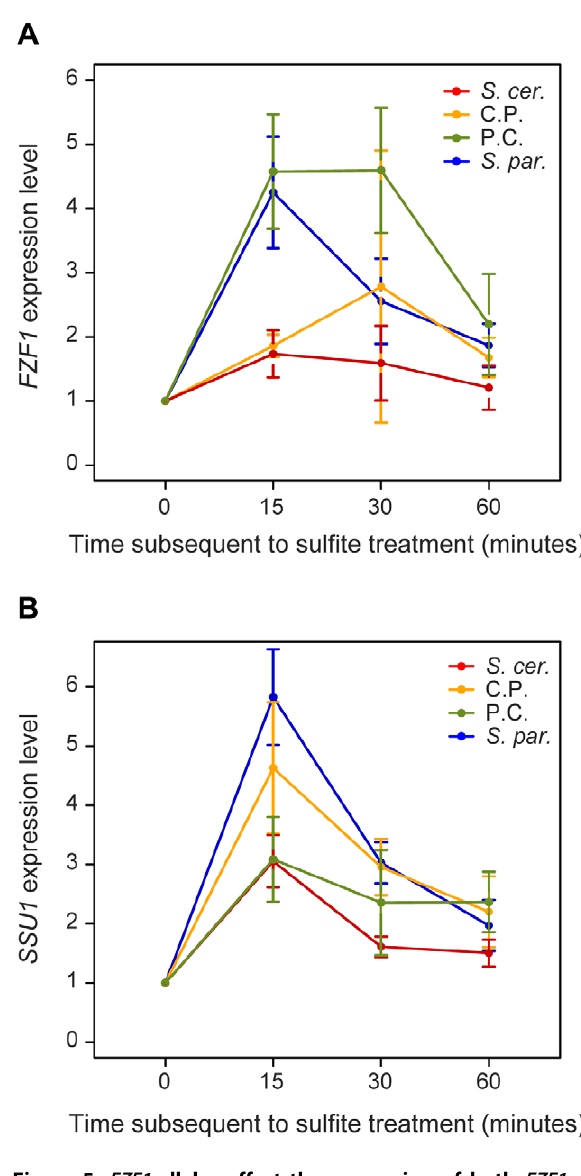
Figure 5. FZF1 alleles affect the expression of both FZF1 and SSU1 subsequent to sulfite treatment. Expression of FZF1 (A) and SSU1 (B) was measured prior to and at three time-points after sulfite treatment for strains carrying four FZF1 alleles: S. cerevisiae ( S. cer , red), S. paradoxus ( S. par , blue), S. cerevisiae 5 9 noncoding with S. paradoxus coding (C.P., gold), S. paradoxus 5 9 noncoding and S. cerevisiae coding (P.C., green). Expression levels were normalized to the 0 time-point. Each point is the mean of 3–4 individual observations. Error bars represent the 95% confidence interval of the mean.